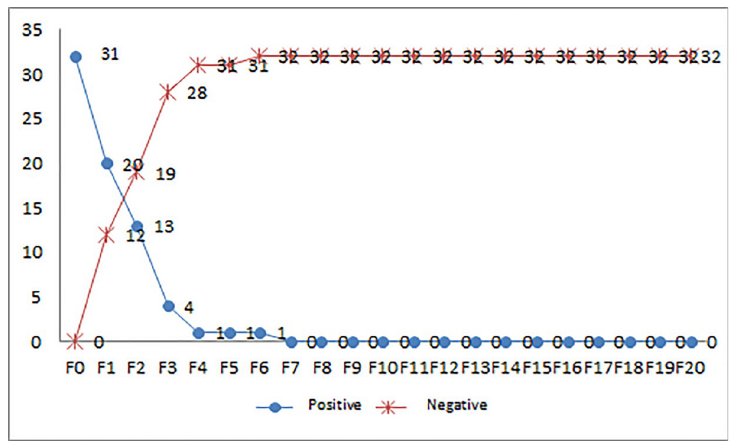
Fig 1. Bacteriological evolution of patients according to the microscopy sputum smears.